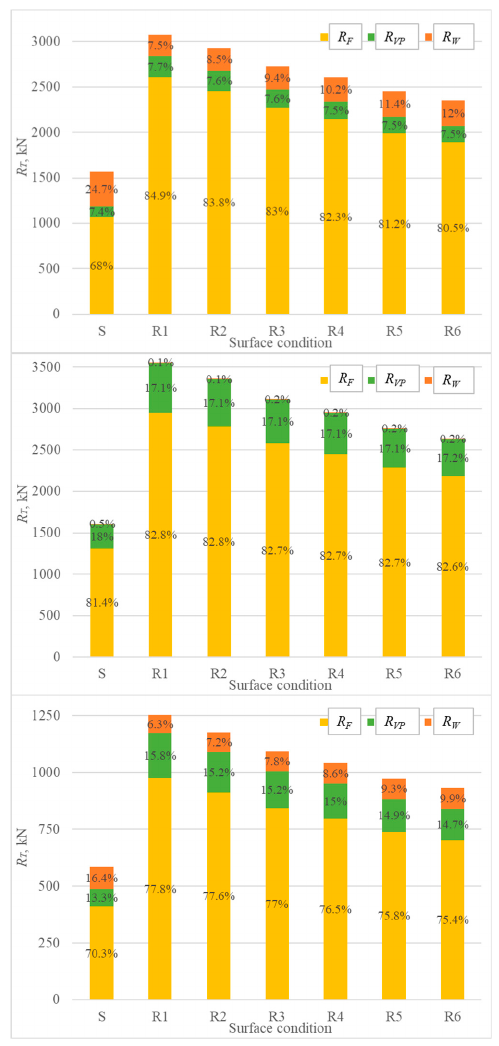
Figure 8. Decomposition of R T for KCS ( upper ), KVLCC2 ( middle ) and BC ( lower ) for smooth and fouled surface condition.